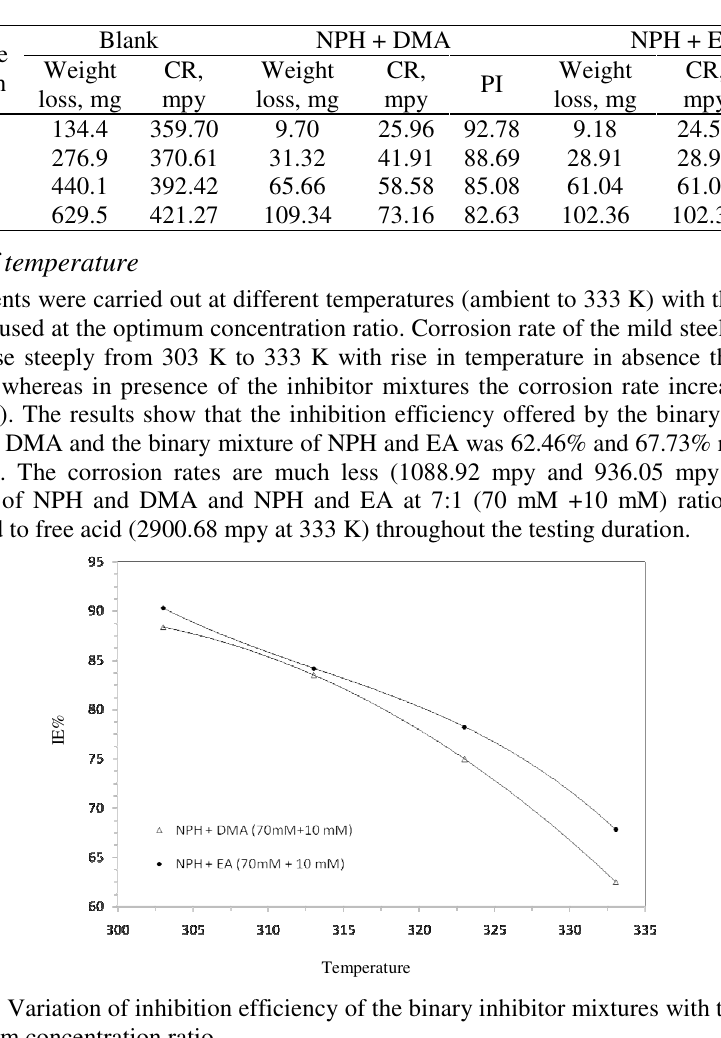
Table 2. Corrosion parameters in absence and presence of inhibitors at different exposure